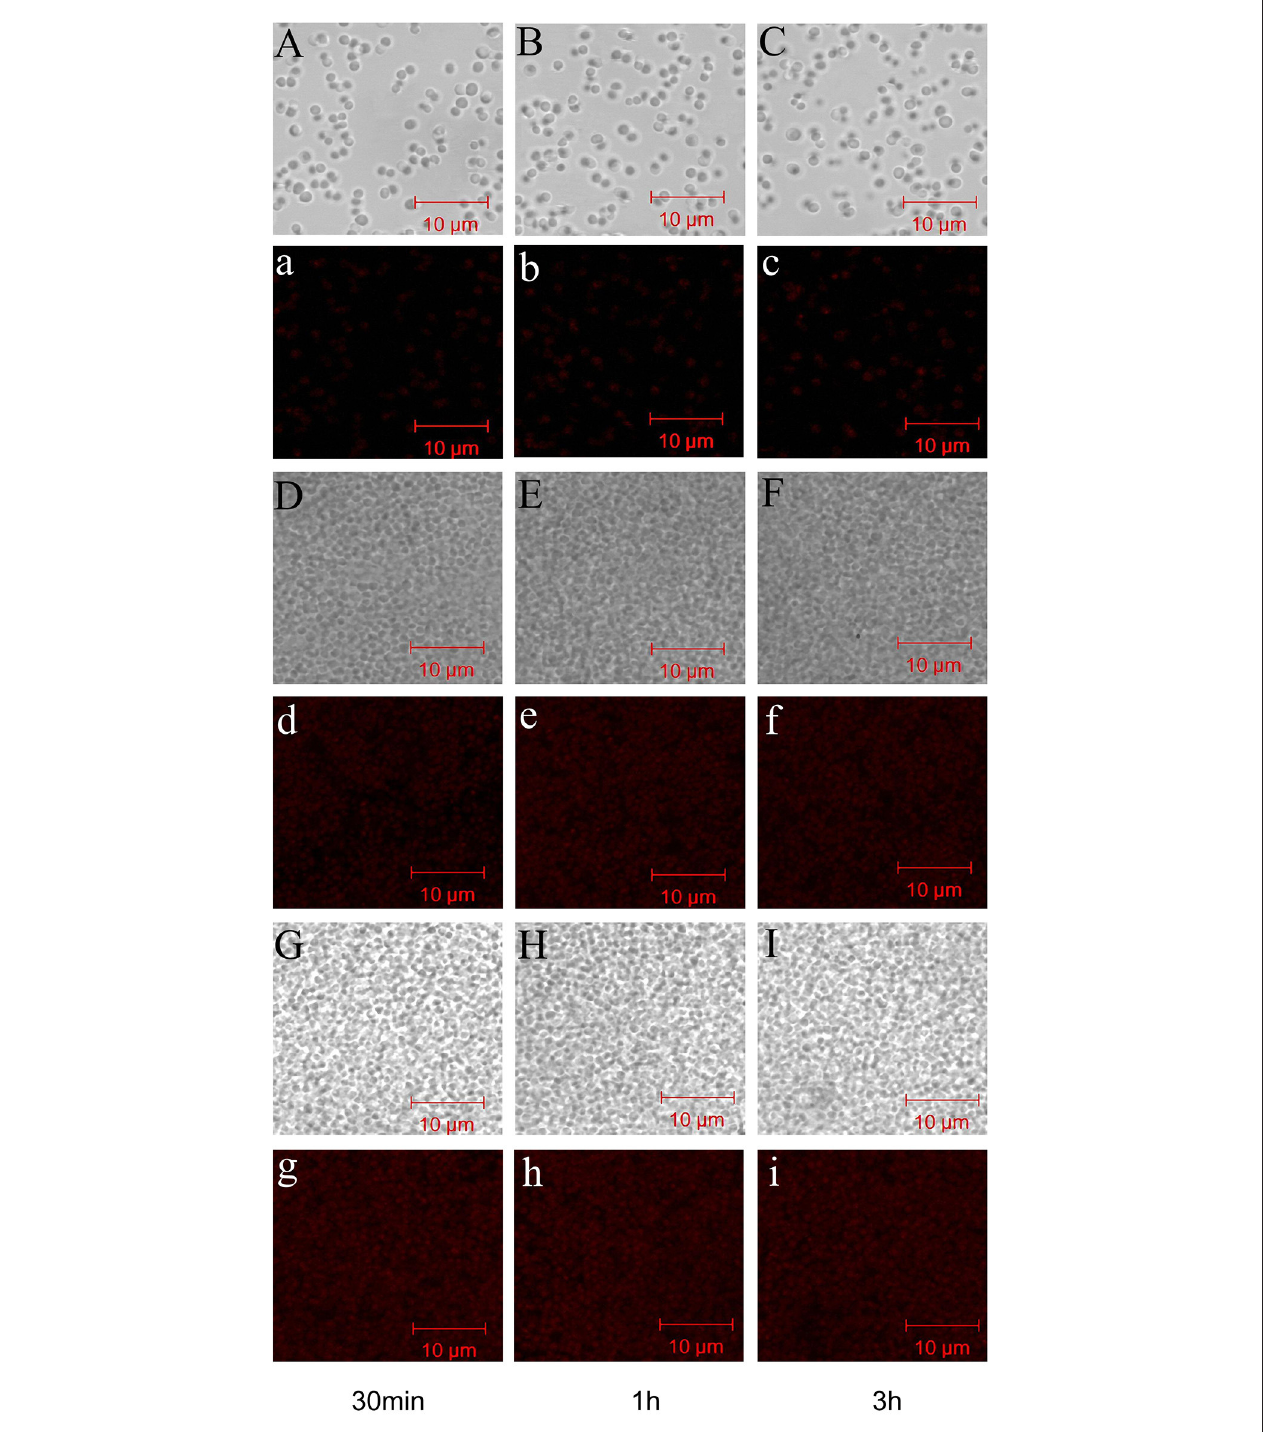
FIGURE 7 | CLSM images showing the uptake of doxorubicin hydrochloride in S. xylosus . (A–C) Images of S. xylosus treated with only doxorubicin hydrochloride for 30min, 1 and 3h, respectively. (D–I) S. xylosus treated with CD-g-CS (Q CD = 0.643 × 10 3 µ mol/g) and CD-g-CS (Q CD = 0.6 × 1 0 2 µ mol/g) containing doxorubicin hydrochloride for 30min, 1 and 3h, respectively. (a–i) Bright-field CLSM images.